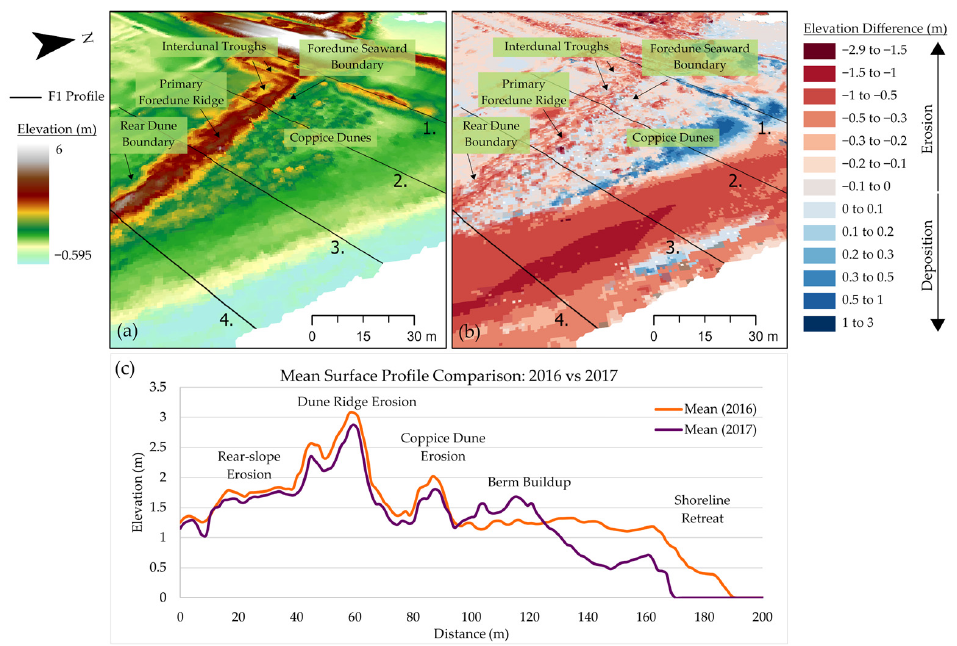
Figure 9. Change analysis for Follett’s Site 1. ( a ) A 3D model of 2016 USACE’s edited topobathy lidar-derived DEM with 4 shore perpendicular transects used to compare pre- and post- storm beach profiles within Follett’s Site 1; ( b ) DEM difference map created using USACE’s 2016 and BEG’s 2017 surface elevation data draped over the 2016 elevation model to show changes to the site after Harvey; ( c ) The 2016 and 2017 mean profiles for transect 2 overlayed for comparison. Scarped shorelines and backbeach areas were observed along Follett’s Site 2 (Figure 10b) and in the subtle post-storm concave beach profile in Figure 10c.